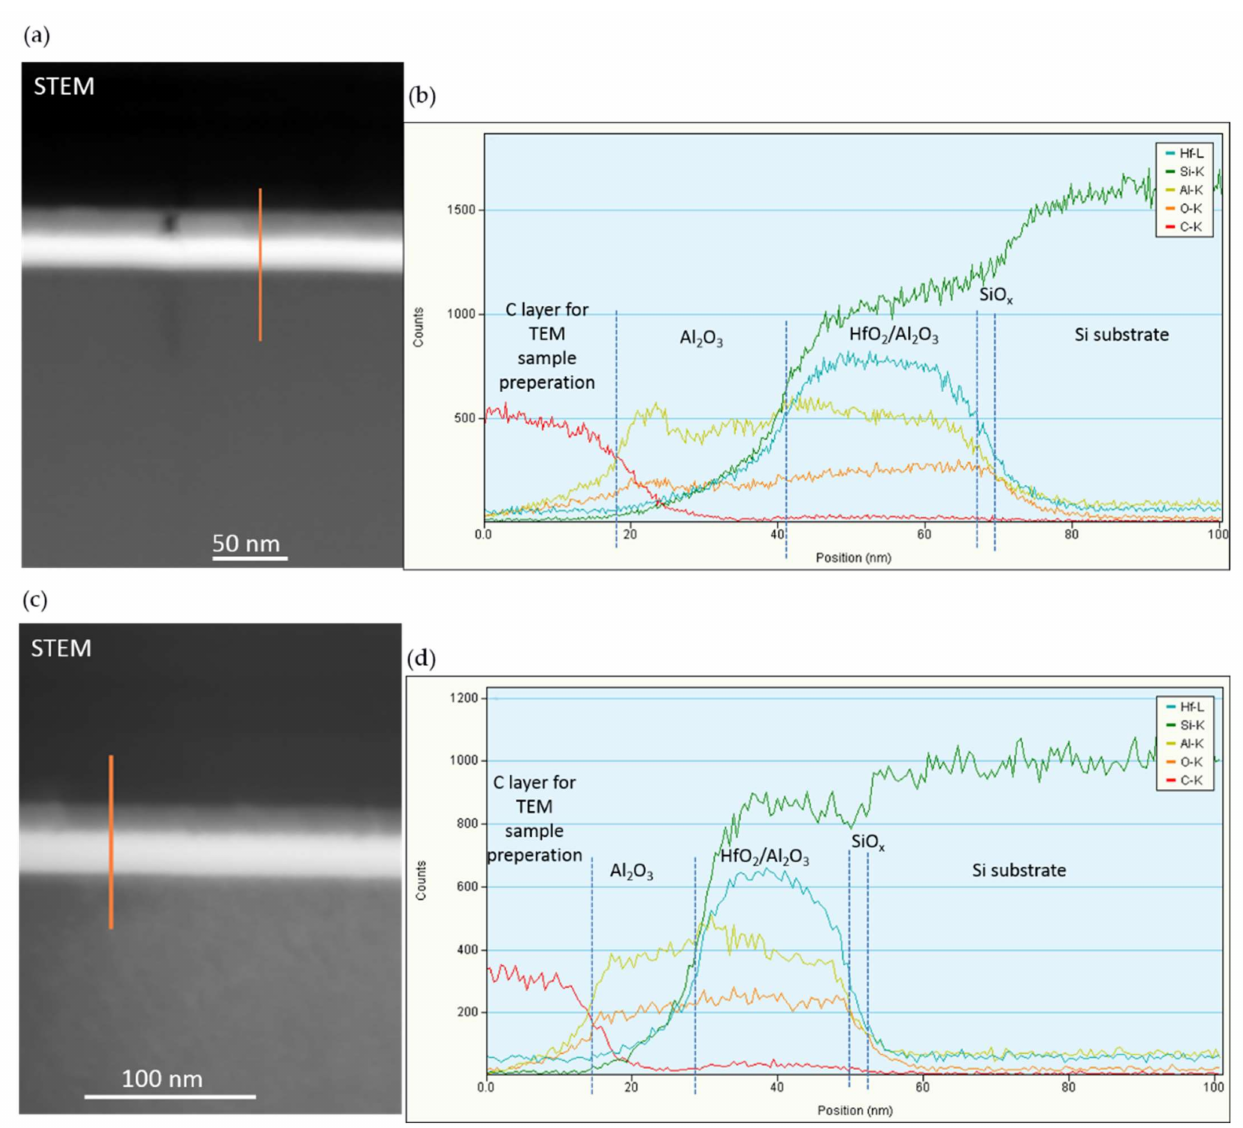
Figure 3. Qualitative chemical analysis (EDS) of nanolaminate 5 × (20:5) HfO 2 —Al 2 O 3 layers with 2.4 nm SiO 2 and BO (Al 2 O 3 ); STEM images after ( a ) and before annealing ( c ) with marked line-scan; diagrams of the elements distributions ( b – d ) recorded along marked